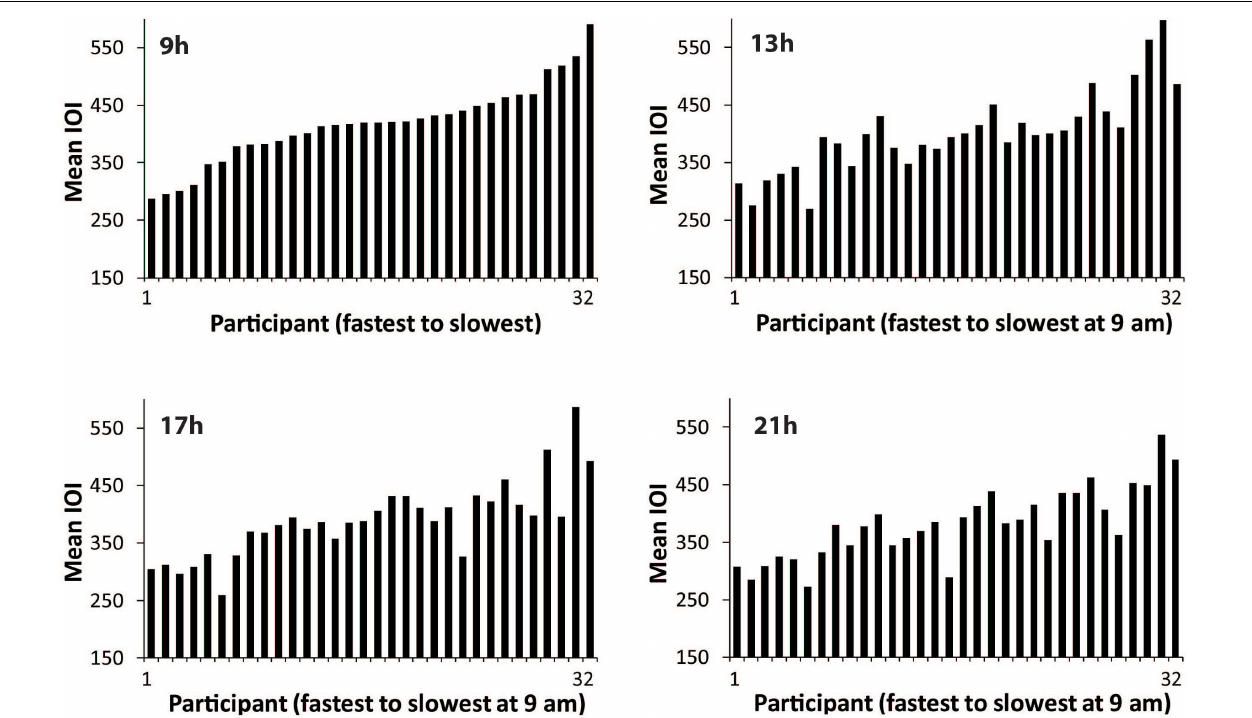
FIGURE 2 | Distributions of performers’ mean SPR values (mean IOI in ms) for the Familiar melody, ordered at each testing session from fastest to slowest performer according to 09 h. Each bar = one performer.